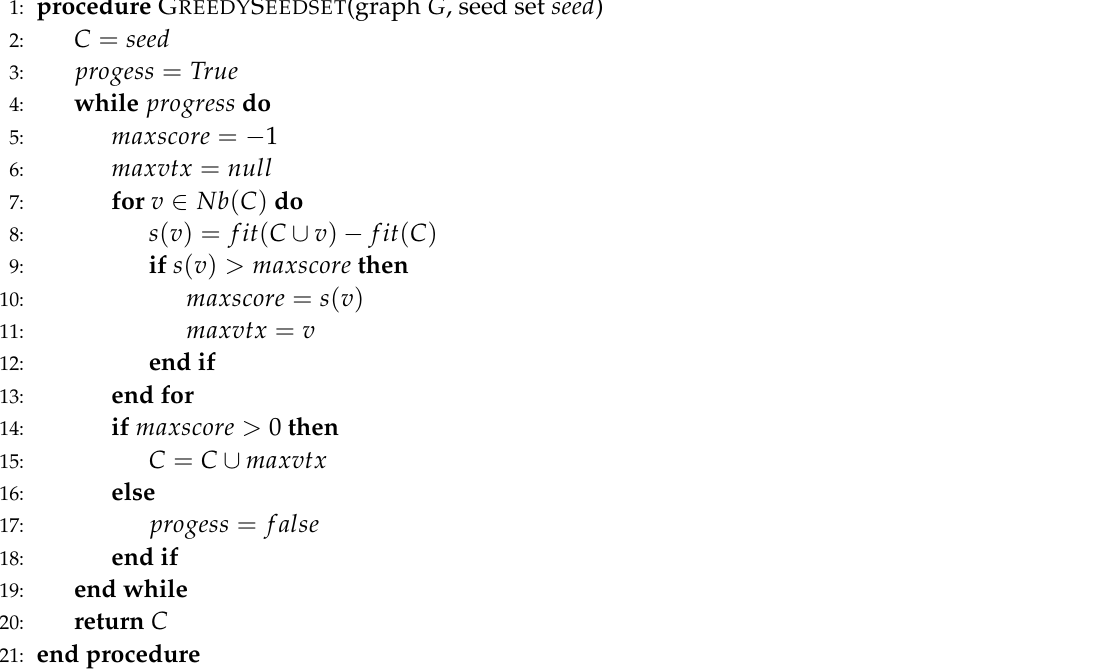
Algorithm 2 Static, Greedy Seed Set